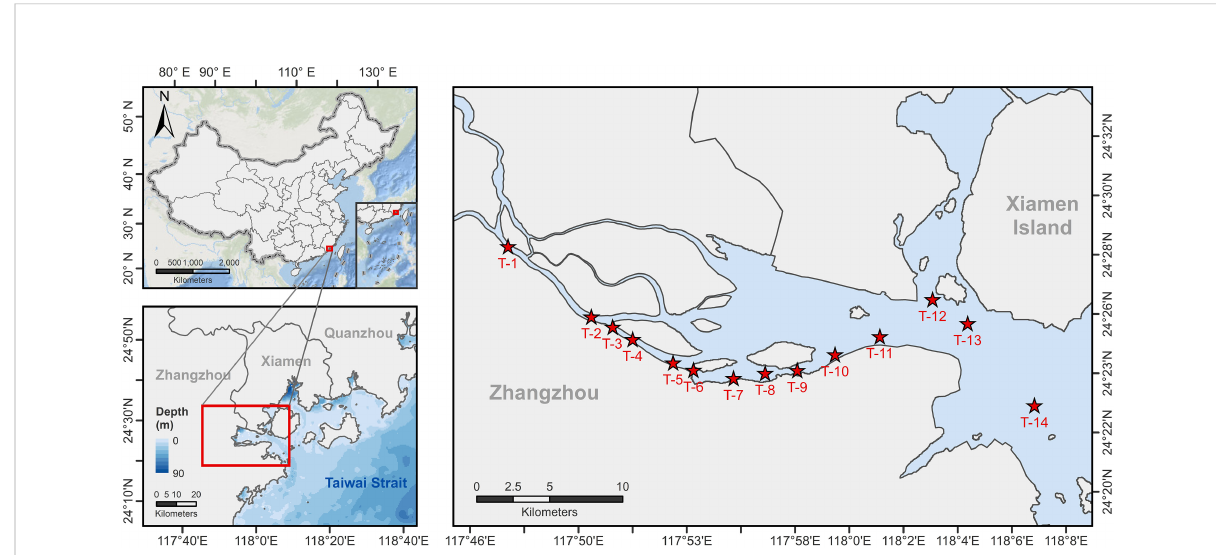
FIGURE 1 Station map for this study. The red stars show the 14 stations where incubation experiments were conducted and environmental parameters were collected during the study, with T1-T11 distributed along the main axis of the Jiulong River Estuary and T12-T14 representing the nearshore stations where surface salinity is above